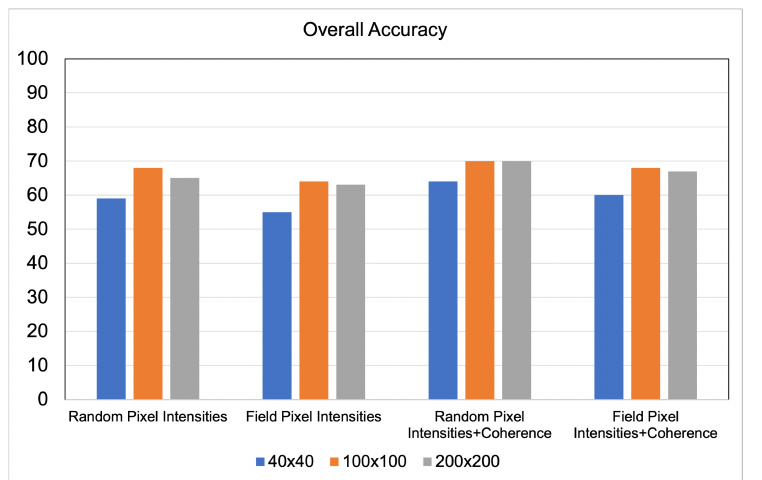
Figure 6. The comparison between the impact of the different multi-looking window sizes on overall accuracy achieved by SVM in pixel